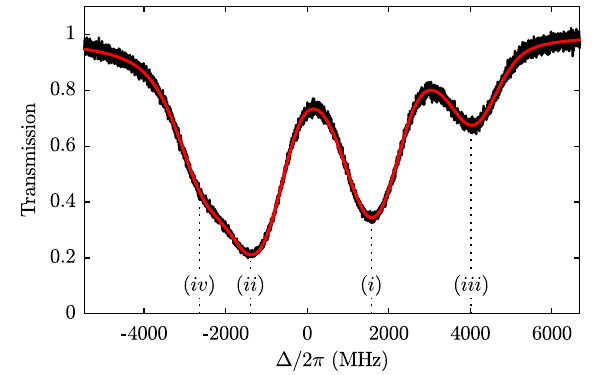
FIG. 2. Transmission spectrum of the w d ¼ 75 nm, l ¼ 200 μ m slot waveguide with an atom density of N ≈ 3 . 5 × 10 14 cm − 3 . The red curve is a fit of our theory model. The dotted lines indicate the transition frequencies from the Rb 85 S 1 = 2 F ¼ 2 (i), F ¼ 1 (iii), F ¼ 2 (iv) to the P F ¼ 3 (ii) and Rb 87 S 1 = 2 3 = 2